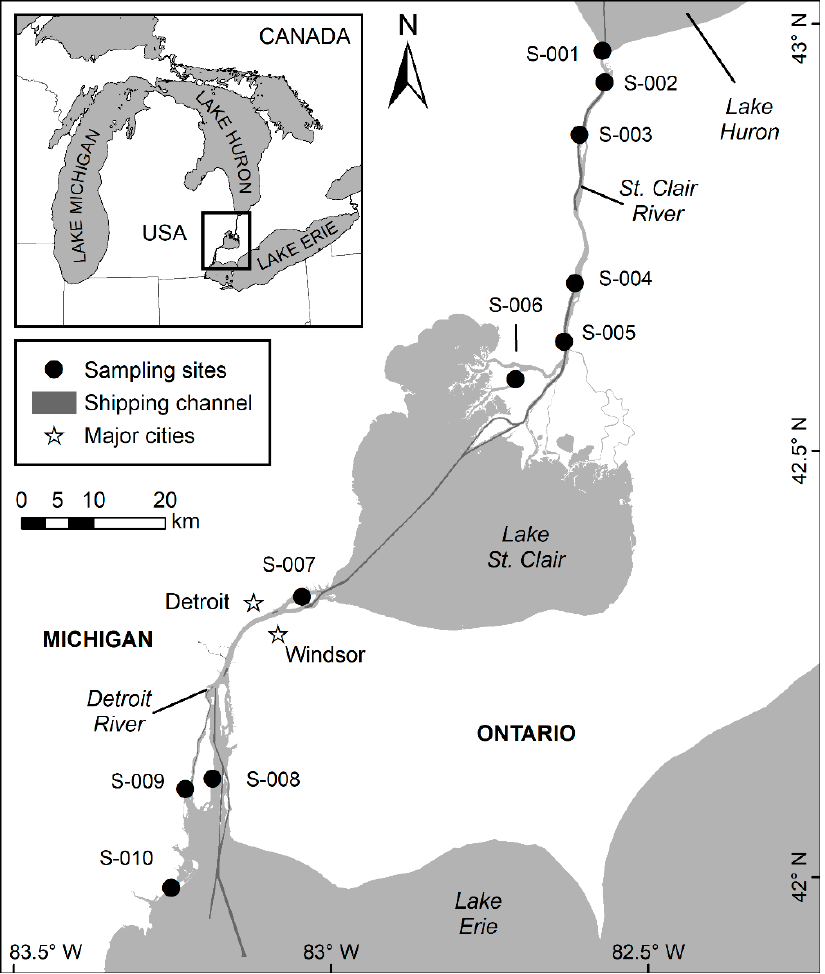
Figure 1. Map of the St. Clair–Detroit River System showing locations of sample sites for a shore- line seine survey in relation to metropolitan areas of Detroit, Michigan, USA and Windsor, On- tario, Canada.